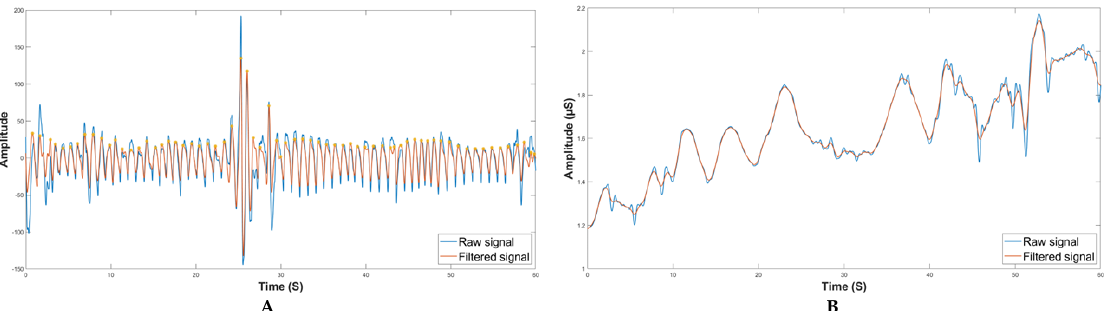
Figure 3. Data cleaning for both PPG and EDA records with the corresponding raw and clean signals. ( A ) Raw and clean PPG signal. ( B ) Raw and clean EDA